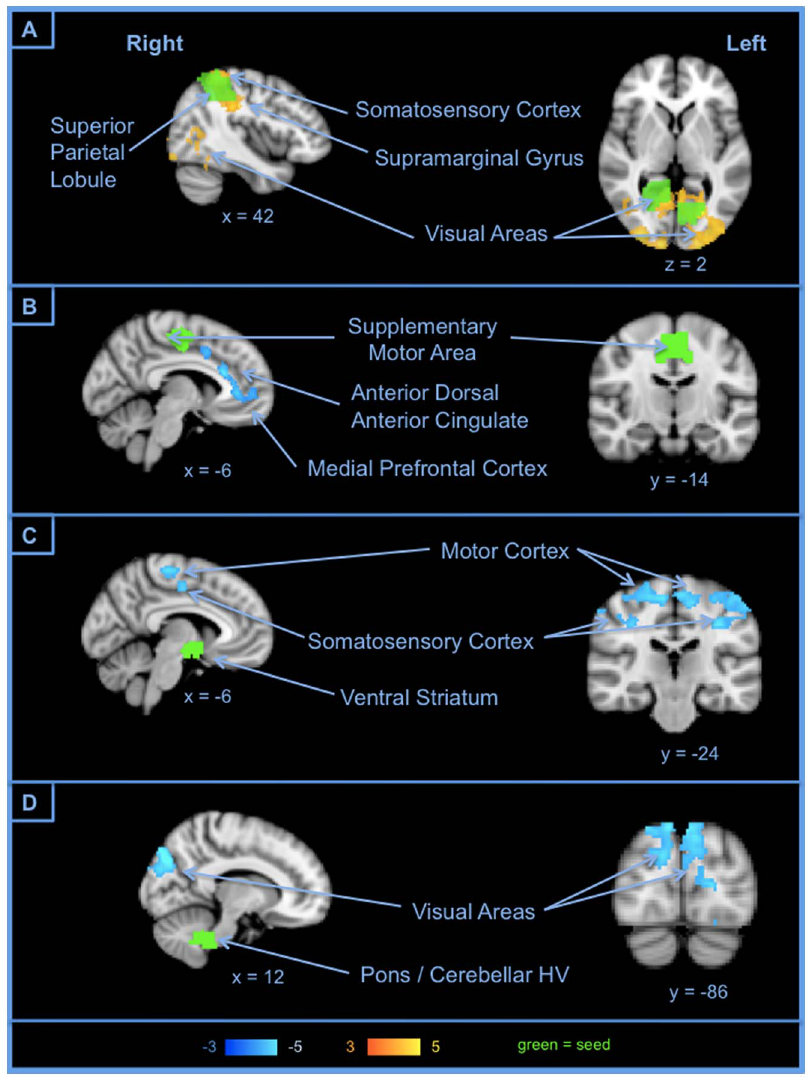
Figure 6. Examples of connections correlated with Negative Affect. NA was reflected in two small networks: within the positively correlated network, greater connectivity was observed with higher NA, whereas within the negatively correlated network greater connectivity was observed with lower NA.